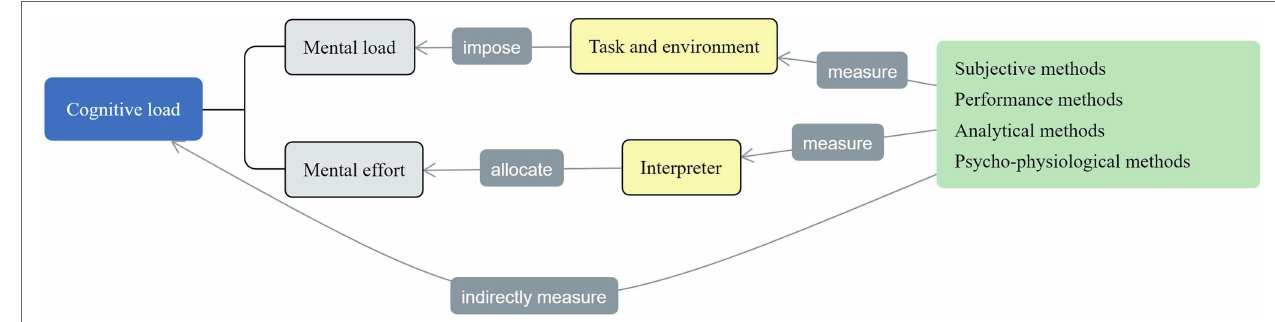
FIGURE 1 | Representation of cognitive load and its measurement in